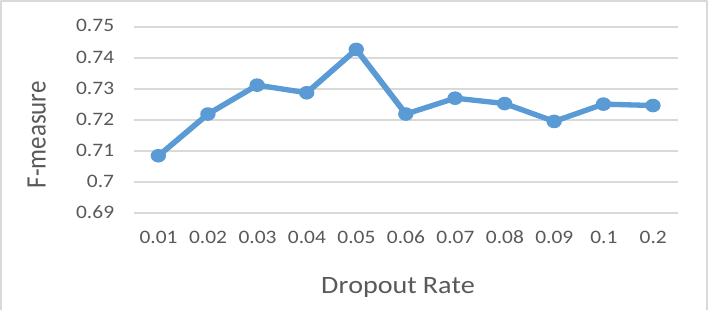
Figure 3. Dependency between the pooling size and the F-measure.